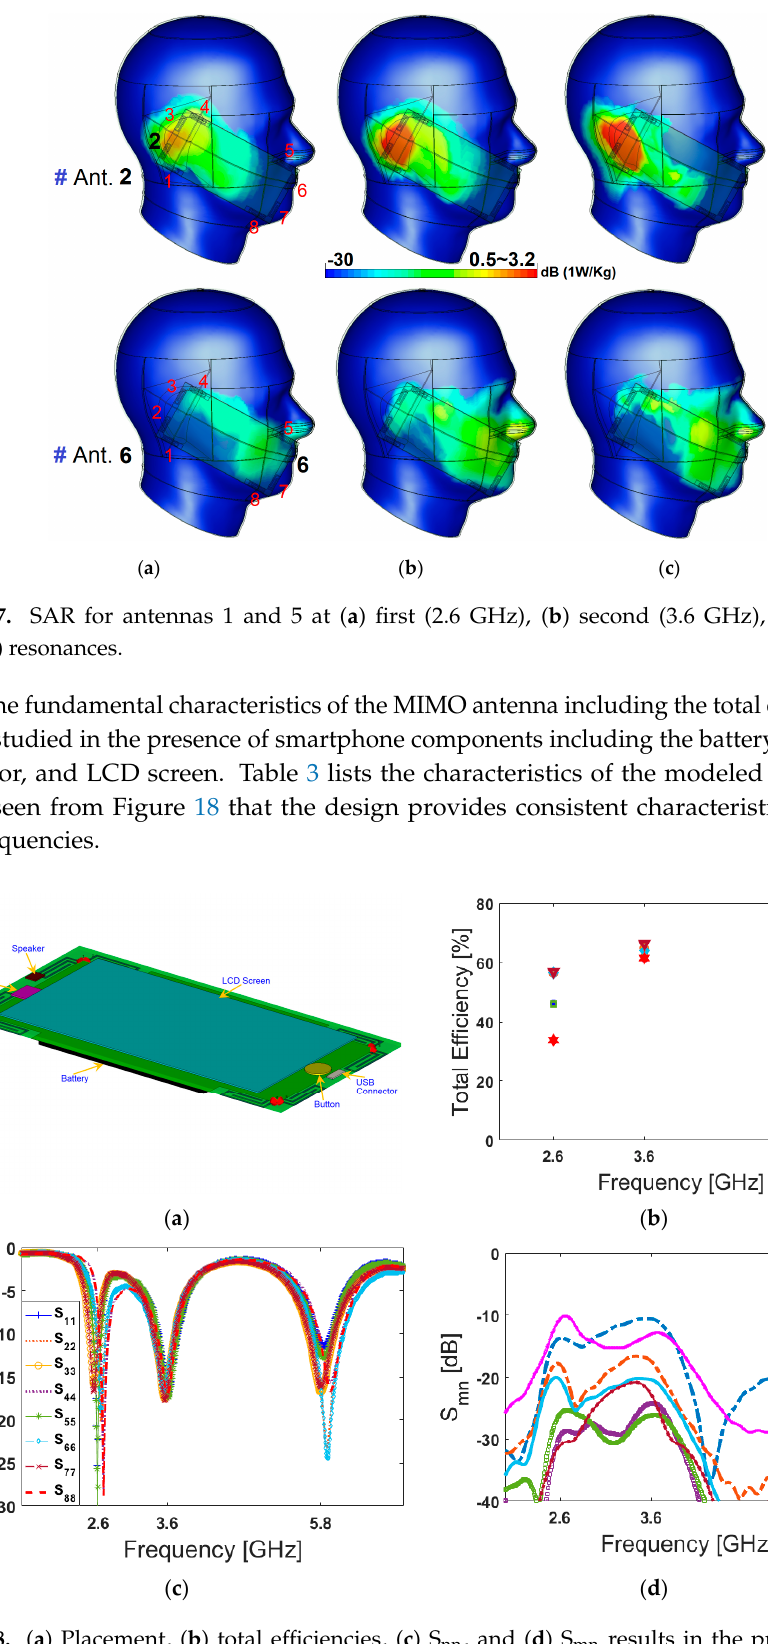
Figure 16. ( a ) Placement, ( b ) total efficiencies, ( c ) S nn , and ( d ) S mn results for the talk-mode scenario.